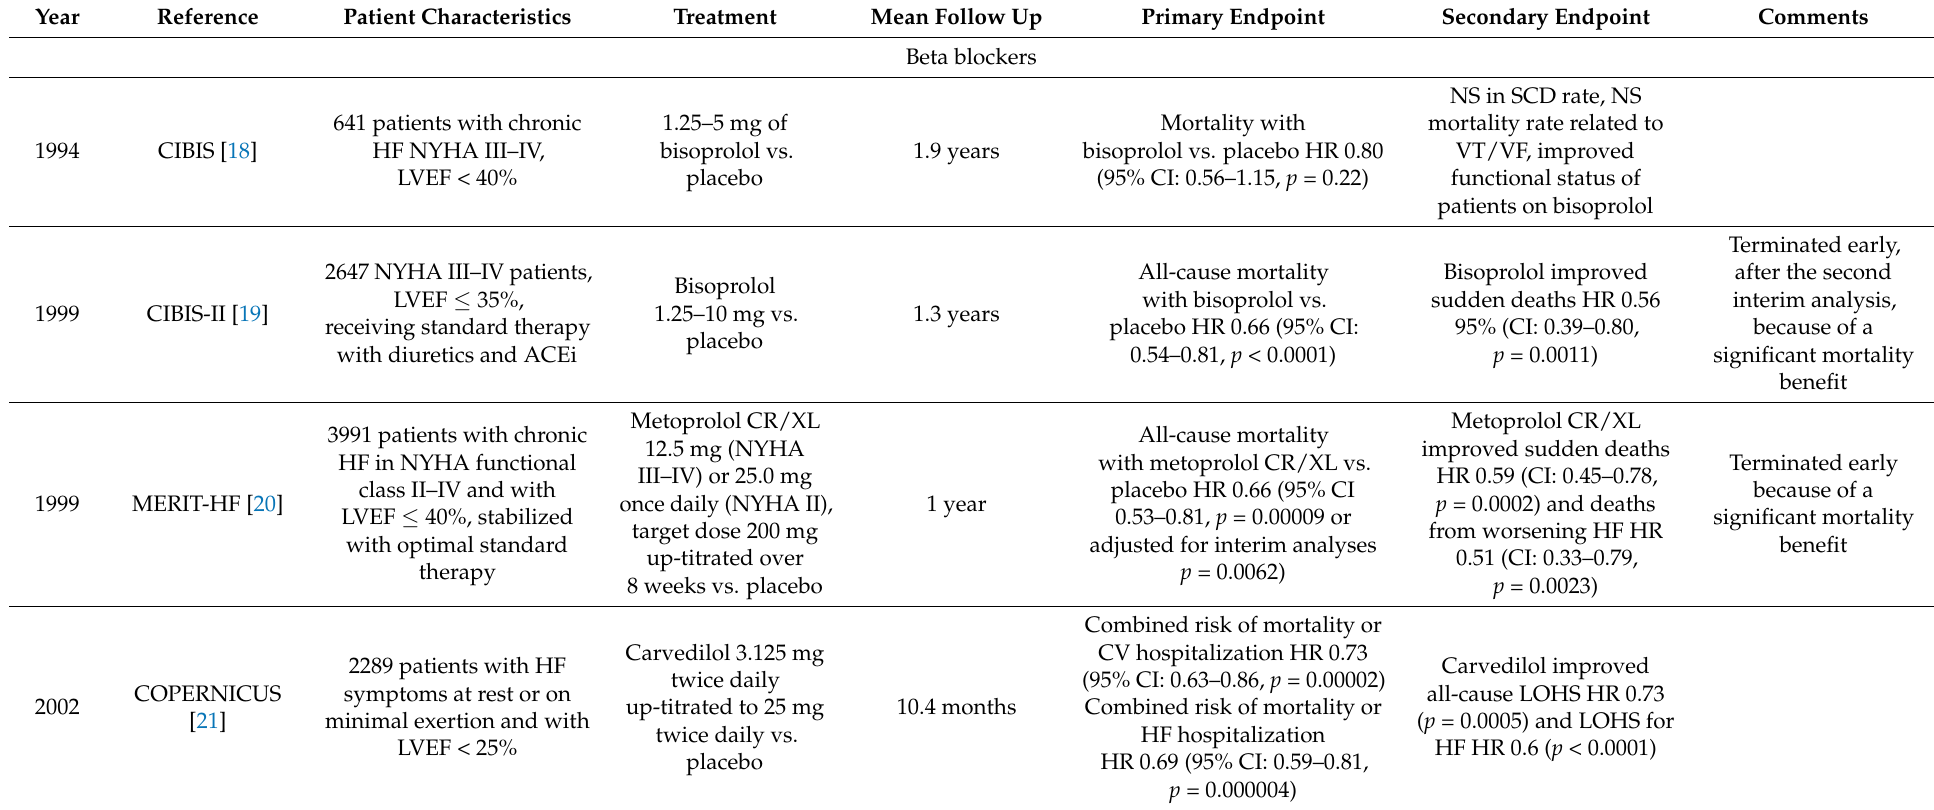
Table 1. Summary of major HFrEF treatment clinical